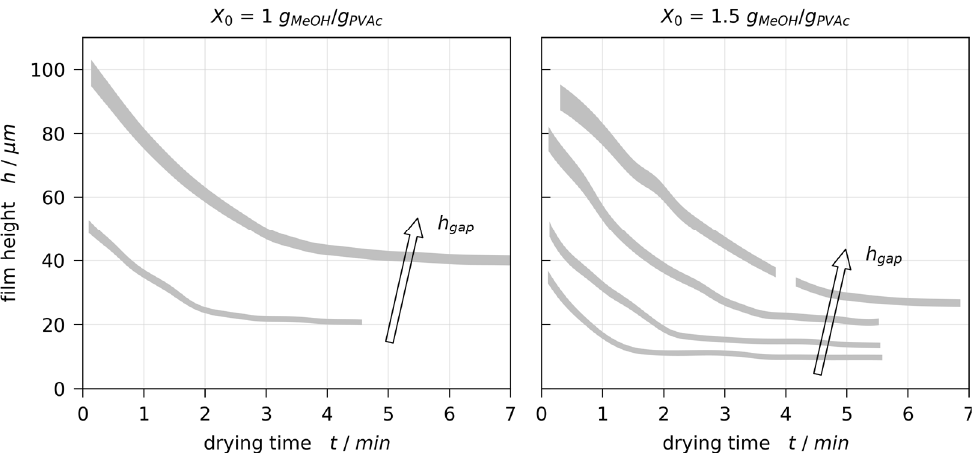
Table 1. Comparison of dry-film thicknesses measured using 3D-µPTV and physical probe. 𝑿 /(𝒈 /𝒈 ) 𝟎 𝑴𝒆𝑶𝑯 𝑷𝑽𝑨𝒄